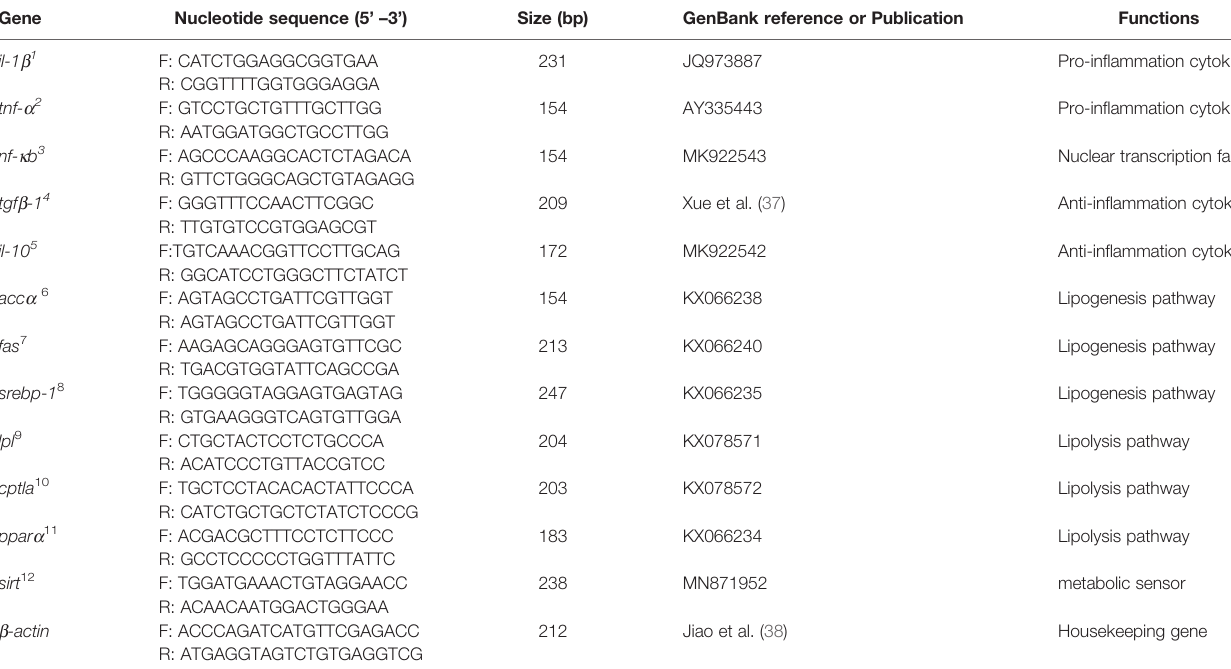
TABLE 2 | Primers for real-time quantitative